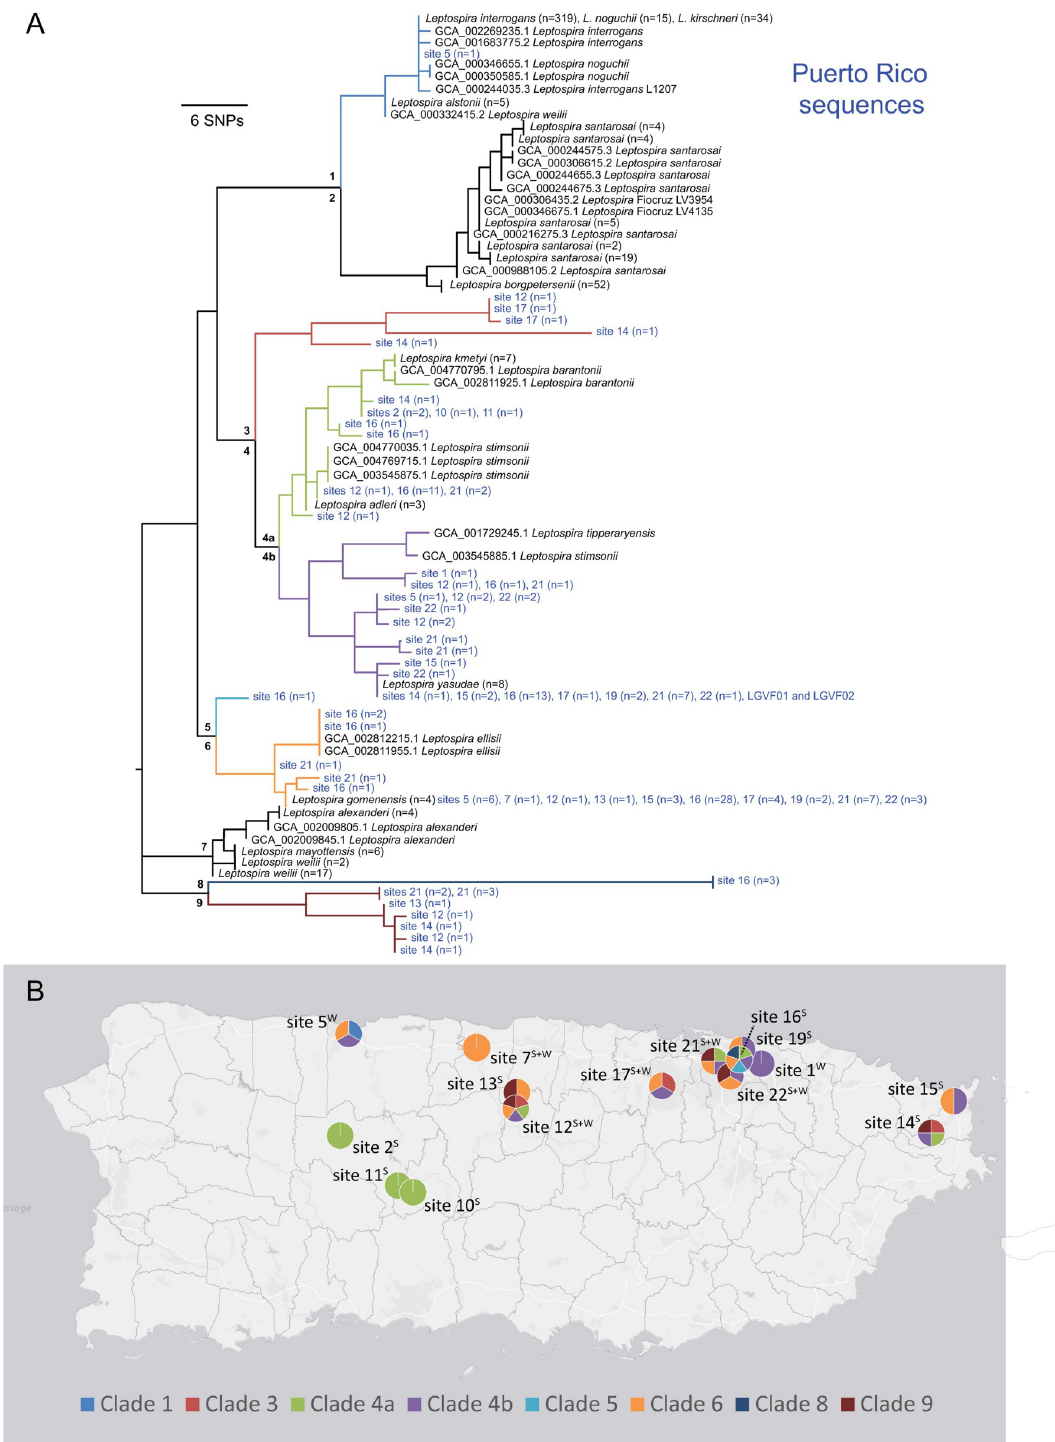
Fig 2. Genetically diverse and previously undescribed lineages of pathogenic Leptospira are widespread in Puerto Rico. A) Maximum likelihood phylogeny constructed using a 202bp segment of the lipL32 gene, including sequences obtained from soil and water samples collected in this study (blue text) and those available in public databases (black text). Nine major genetic clades are represented, seven of which were present in Puerto Rico, including four not previously described. Clades are labelled 1 through 9 on the tree and color coded. B) Sites where each major clade was collected, with colors within the pie charts corresponding to those in